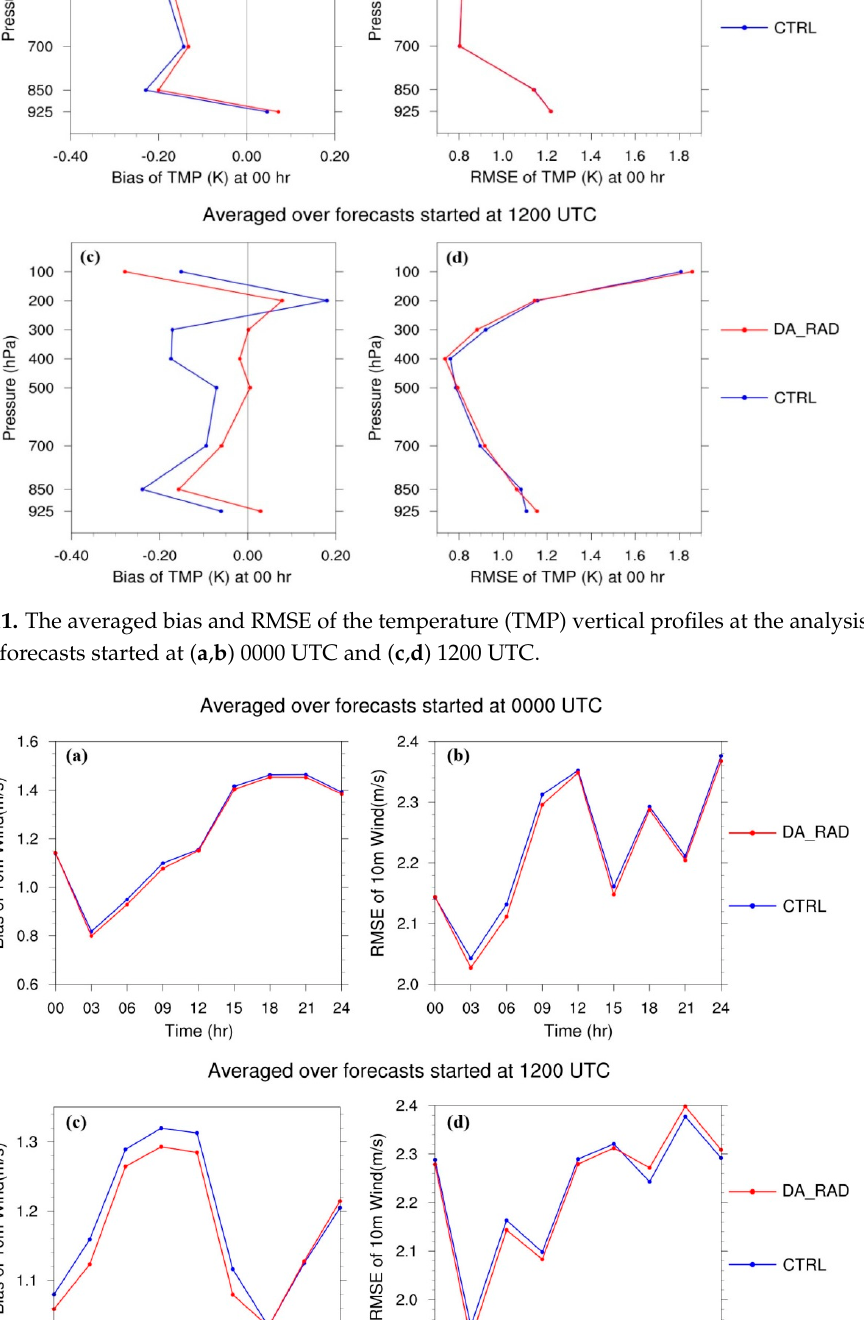
Figure 12. The 3-h average bias and RMSE of the wind at 10 m for forecasts started at ( a , b ) 0000 UTC and ( c , d ) 1200 UTC. and ( c , d ) 1200